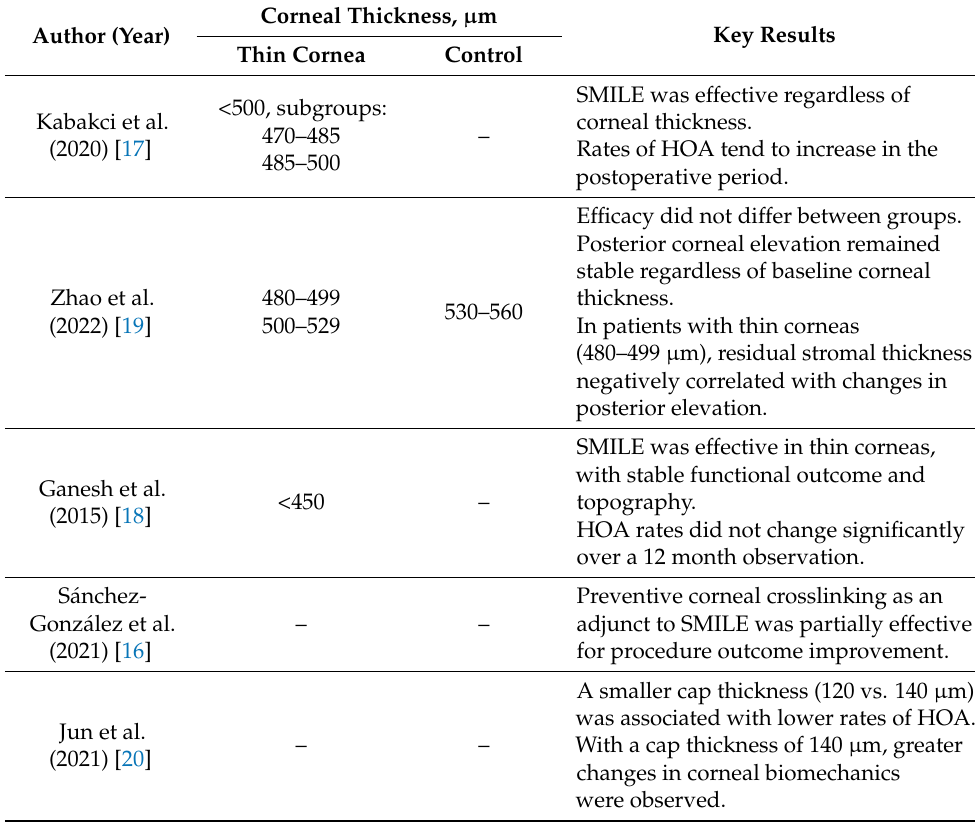
Table 2. Published studies of small-incision lenticule extraction outcomes in patients with thin